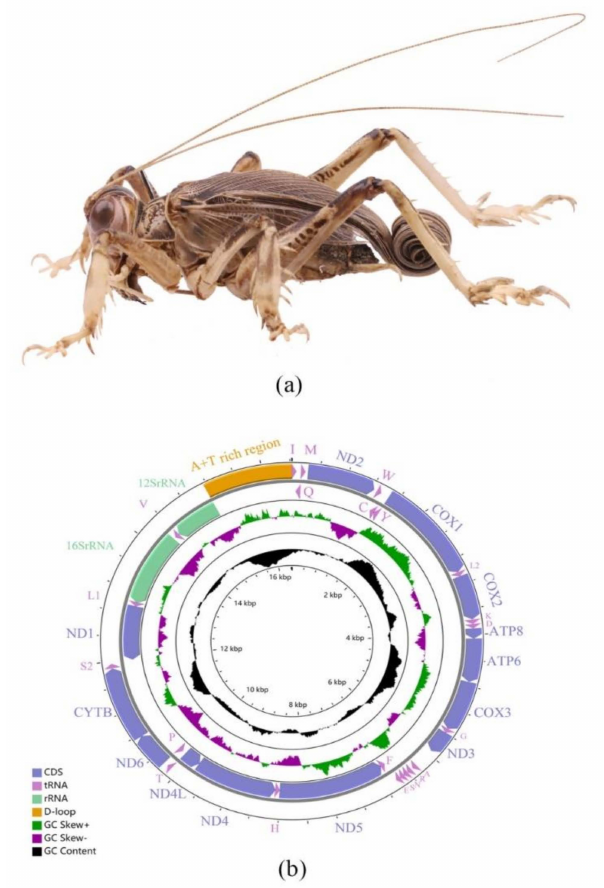
Figure 1. Mitogenome of S. jimo . ( a ) Morphology of S. jimo , lateral view. ( b ) Circular map of the mitochondrial genome.